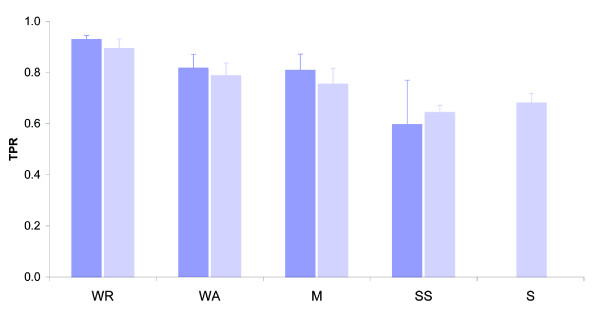
Sensitivity of multiplicity estimators. The average true positive rate (TPR) at a fixed false positive rate of 0.01 when training the data with four different multiplicity estimators: weighted rank (WR), weighted average (WA), median (M) and sum of scores (SS), compared to Single Scores (S). For each estimator the TPR was calculated when considering (dark columns) or not considering (light columns) the Conservation Of Score (COS).